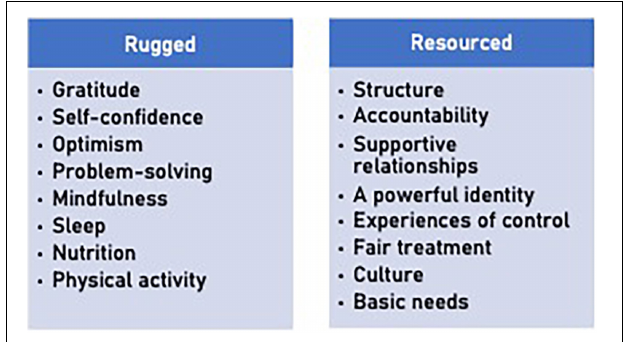
FIGURE 2 | Example of intervention selection of rugged qualities and resources. The factors selected in this Delphi process were selected from an earlier version of Table 1 . The wording of some items has changed slightly over